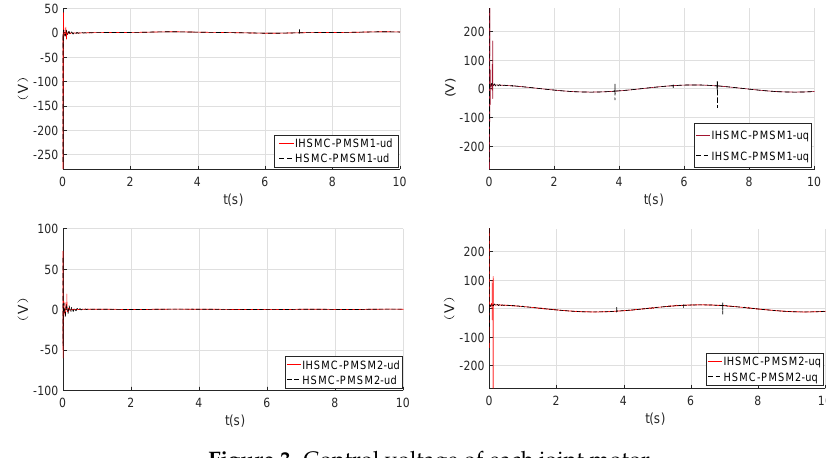
Figure 3. Control voltage of each joint